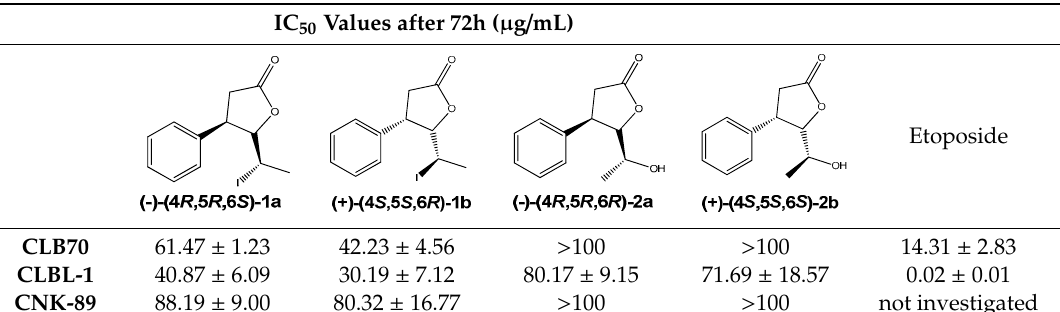
Table 2. Antiproliferative activity of iodololactones 1a,b, hydroxylactones 2a,b and the control—etoposide—against the selected cancer cell lines expressed as IC 50.